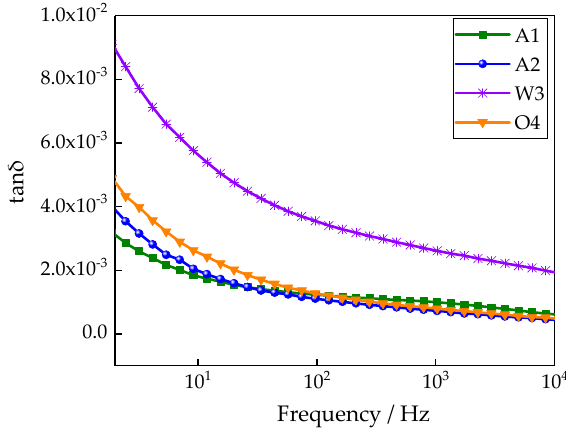
Figure 6. Frequency dependences of the dissipation factors of various samples.